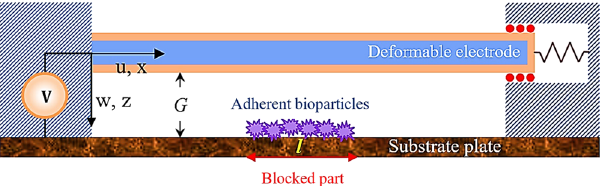
Figure 1. Schematic of the proposed biodetector subjected to the deposited array of biological particles on the coated sensing